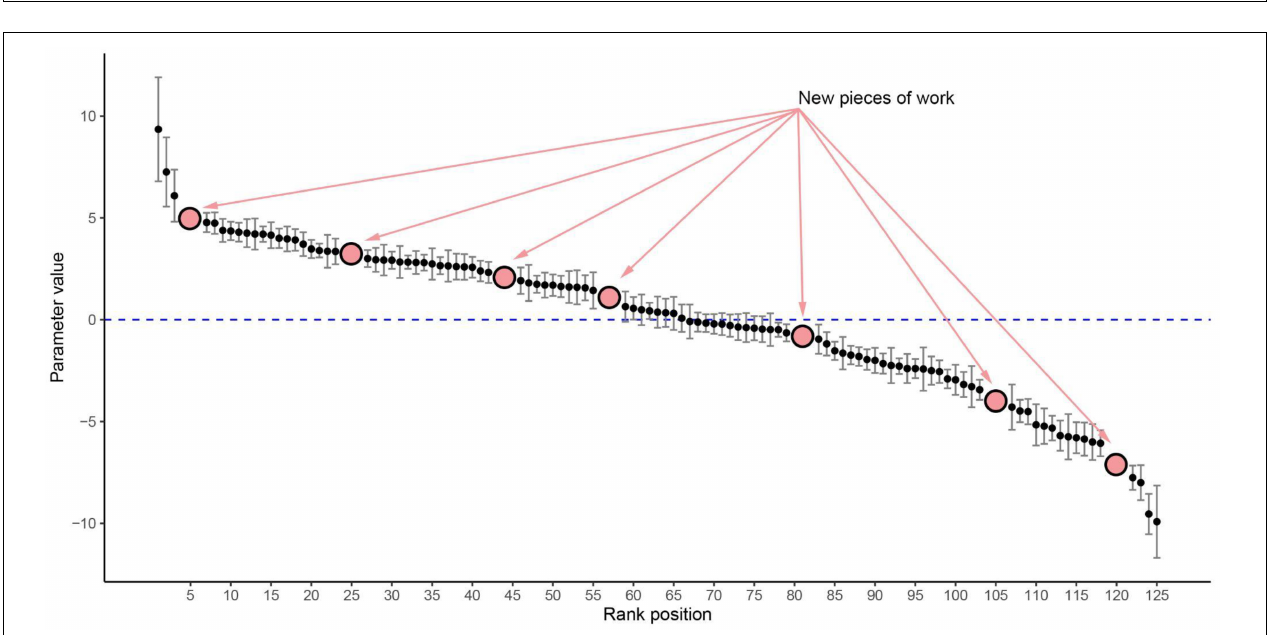
FIGURE 2 | The goal of step 2 is to use the Ruler, with a new ACJ approach, to position new pieces of work against, illustrated hypothetically in the above figure.